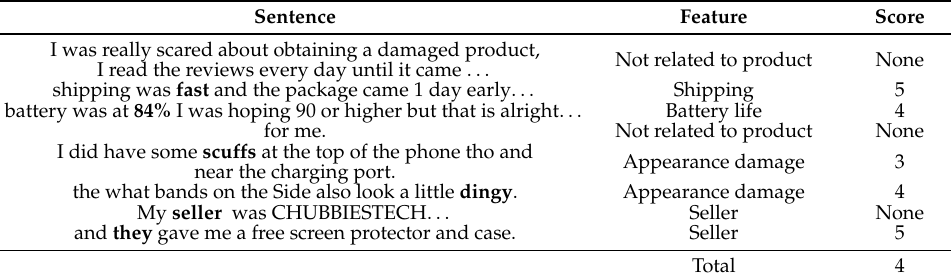
Table 1. Fine-grained sentiment classification